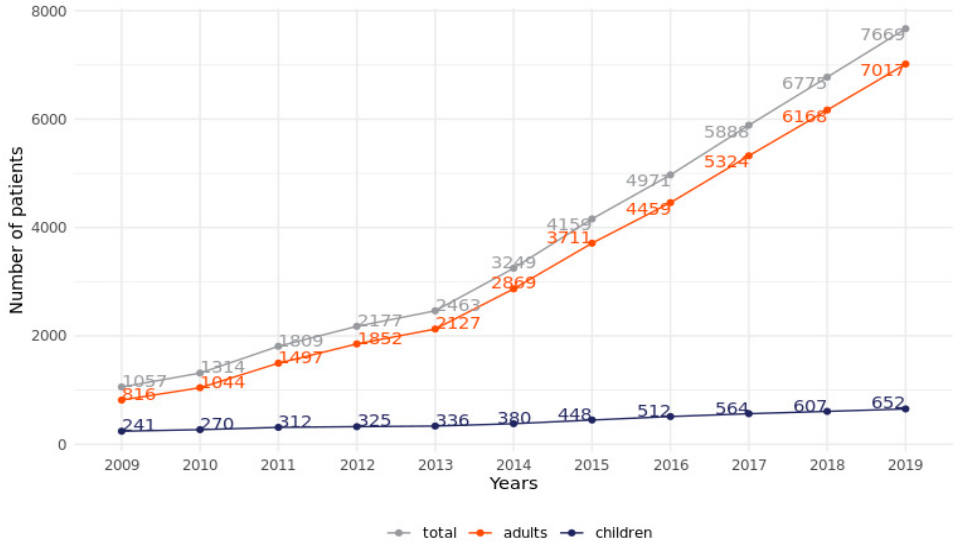
Figure 1. Number of mechanically ventilated patients in 2009–2019.